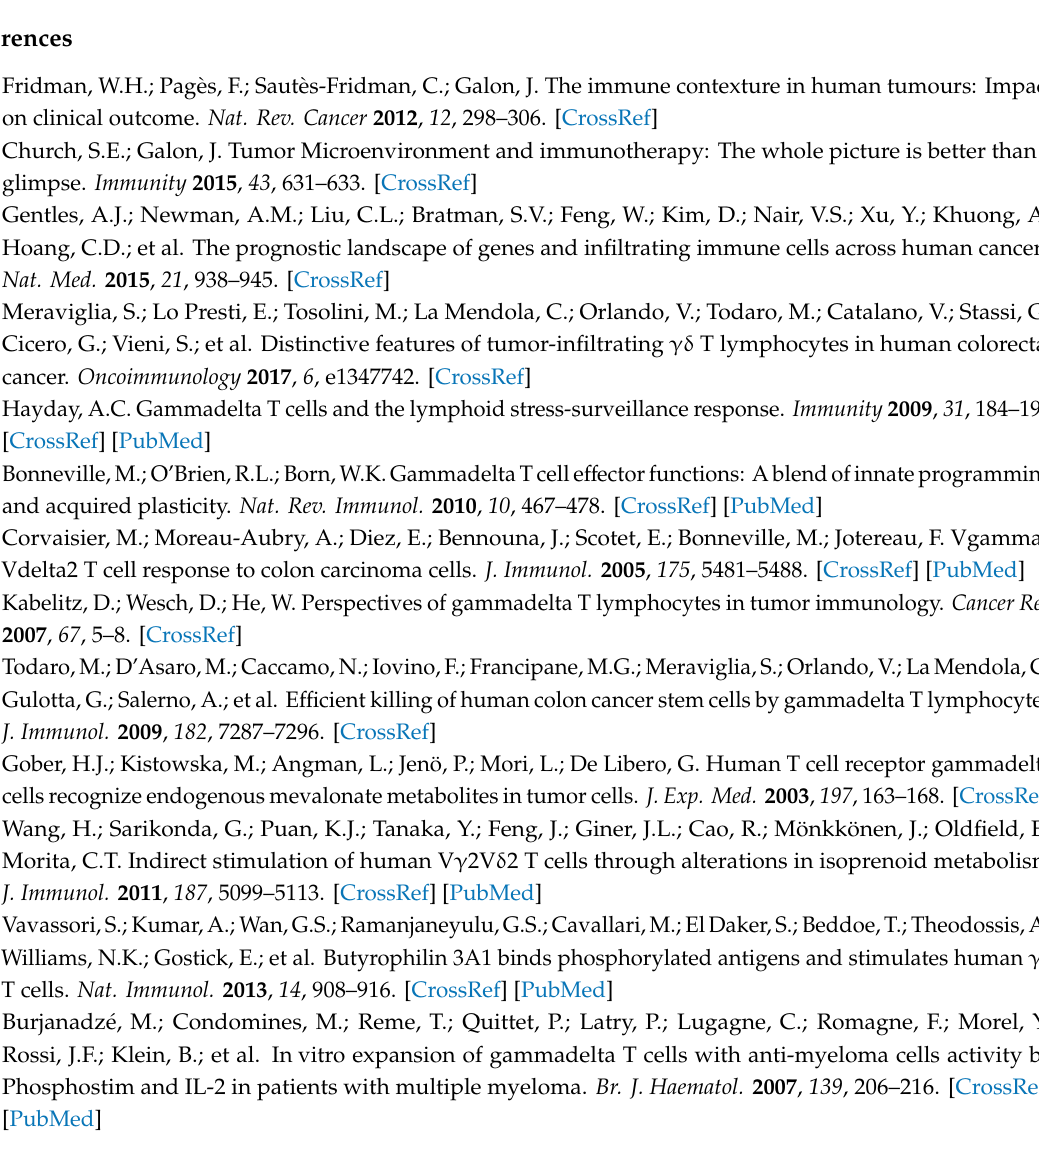
ZA-SPN-expanded V δ 2 T cells can infiltrate colon organoids, Table S1: Pathology features of CRC patients from which tumor cell suspensions and / or organoids were